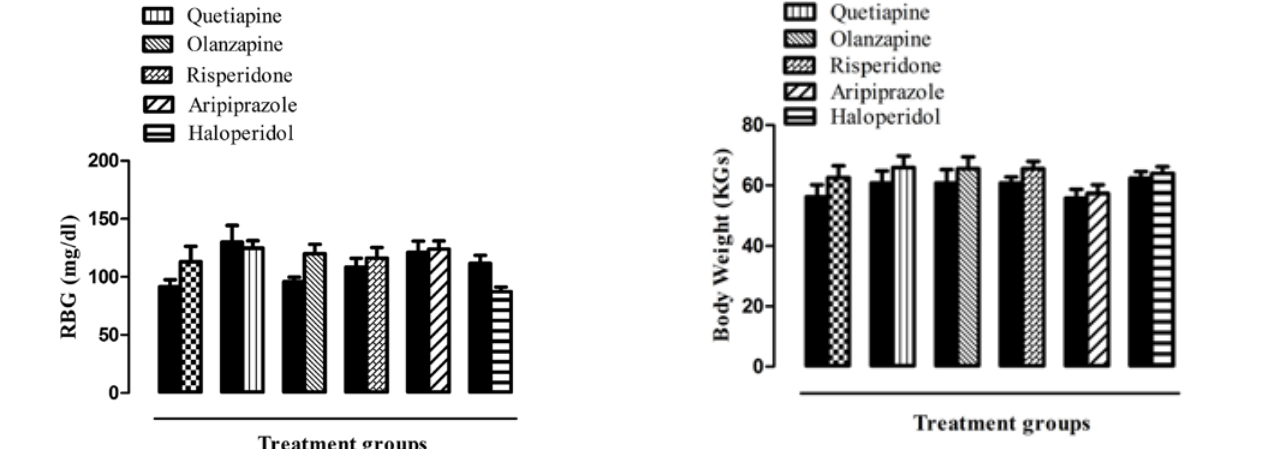
FIGURE 2 - Effect of selected antipsychotics on body weight: Antipsychotic-naïve patients were put on olanzapine in combination with escitalopram, diazepam (STAT, I.V) and haloperidol (STAT, I.M) (OLEDH, n=8), quetiapine (QUET, n=8), olanzapine (OLAN, n=8), risperidone (RISP, n=8), aripiprazole (n=8) or haloperidol (n=8) in therapeutic doses for an average time period of 39, 40, 45, 38, 30 and 33 days respectively showing no significant change in body weight as compared to antipsychotics-naïve patients (n=8) (ANOVA followed by Bonferroni’s Multiple Comparison Test) (P > 0.05).